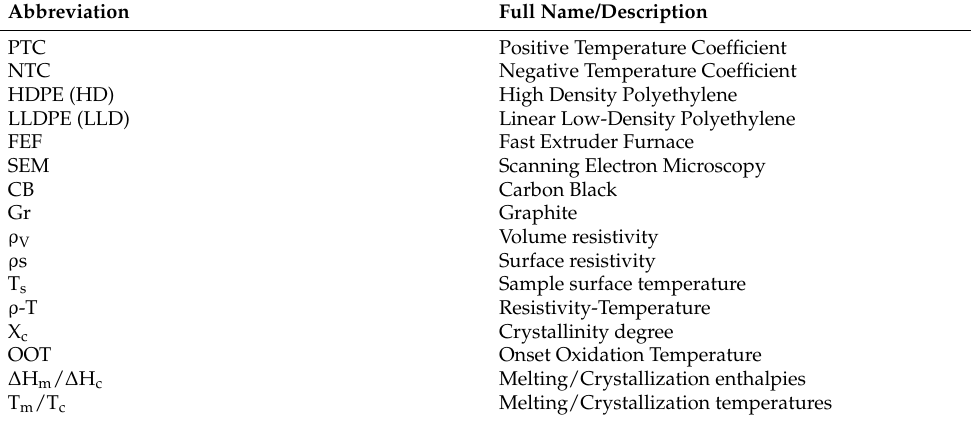
Table 1. List of